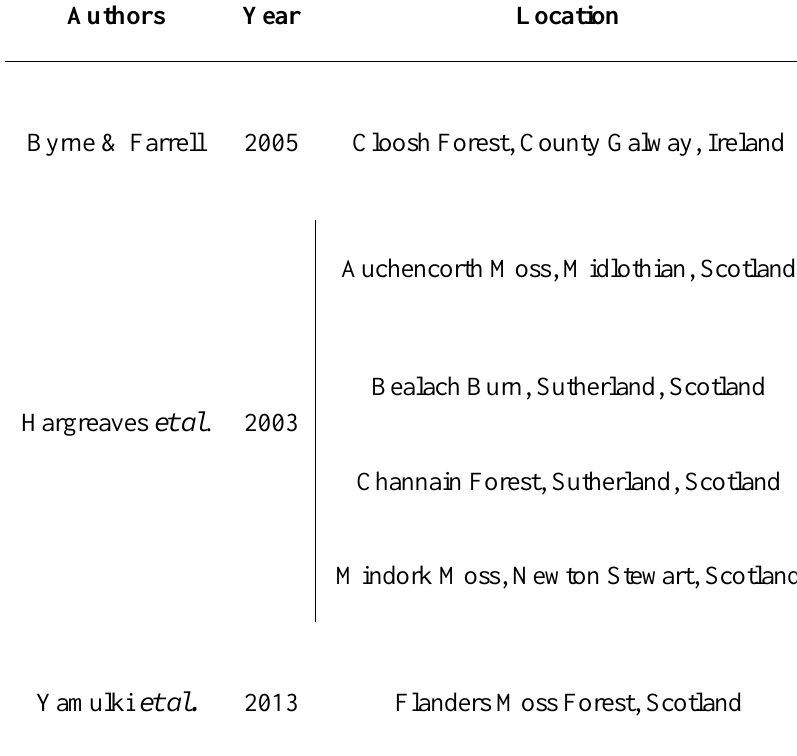
Table 2. Published empirical studies on carbon in afforested peat bogs in the UK and Ireland.